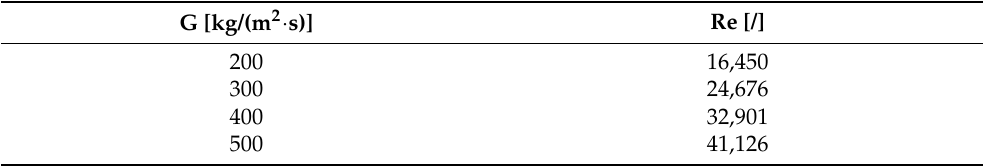
Figure 7. Variation in heat transfer coefficients according to various mass fluxes at constant saturation temperature and heat flux and ( − 20 °C and 20 kW/m 2 ). Table 4. Variation in Reynolds number with respect to different mass fluxes at constant saturation temperature ( − 20 °C) and heat flux (20 kW/m 2 ).